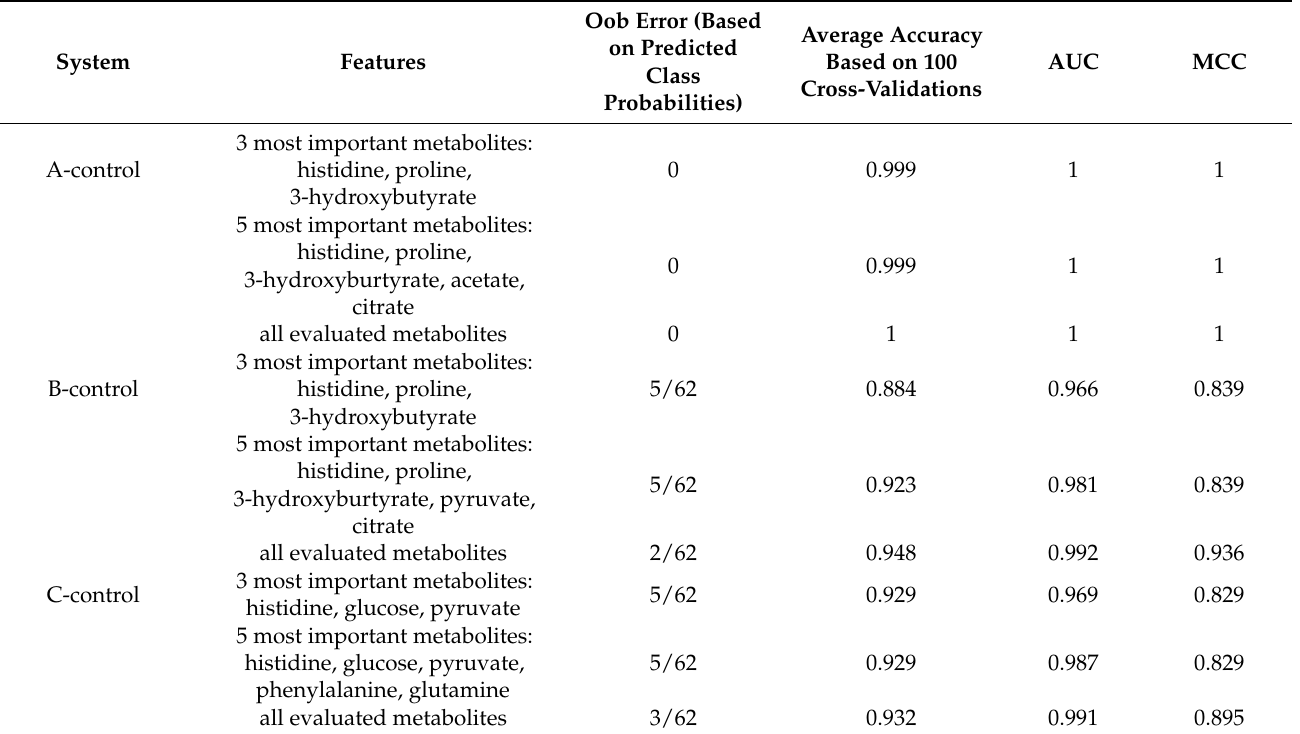
Table 2. Result from RF discriminatory analyses of binary systems patients-controls, AUC values derived from ROC curve, MCC–Matthews correlation